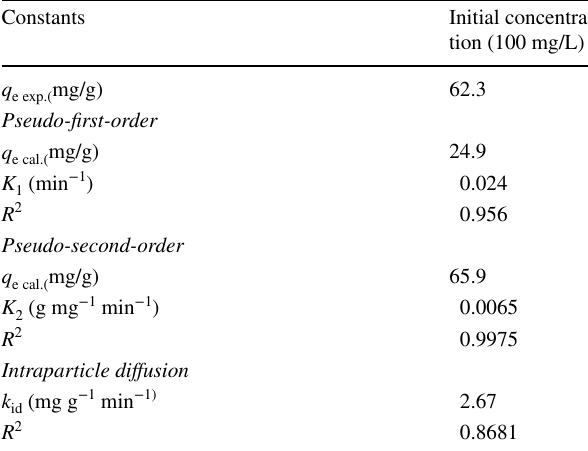
Table 3 Pseudo-first-order, pseudo-second-order and intraparticle dif- fusion rate for adsorption of Cd (II) on algal biomass Constants Initial concentra-